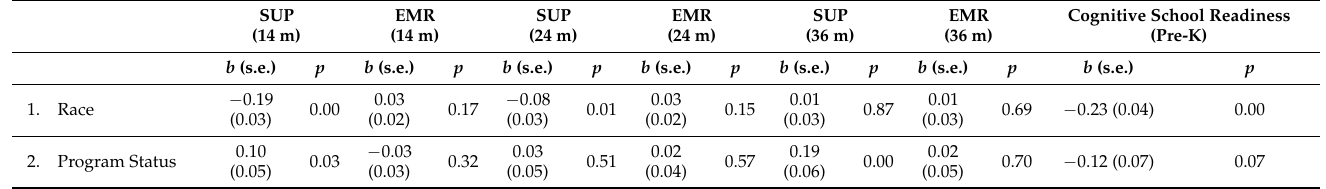
Table 3. Results from the Regression of the Final Model Parameters on the